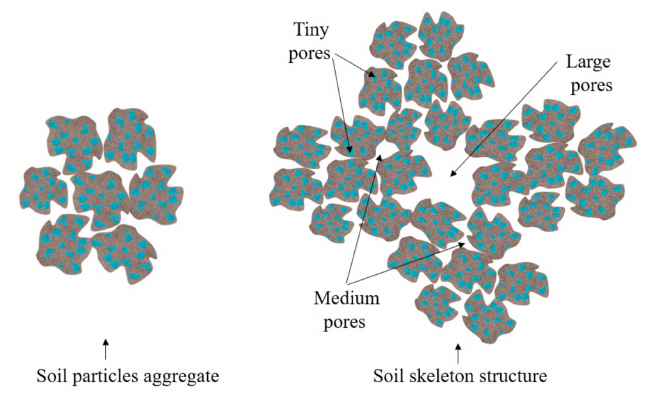
Figure 6. Soft clay structure diagram. In the diagram, blue spaces represent the water-filled pore space in the particle and aggregate